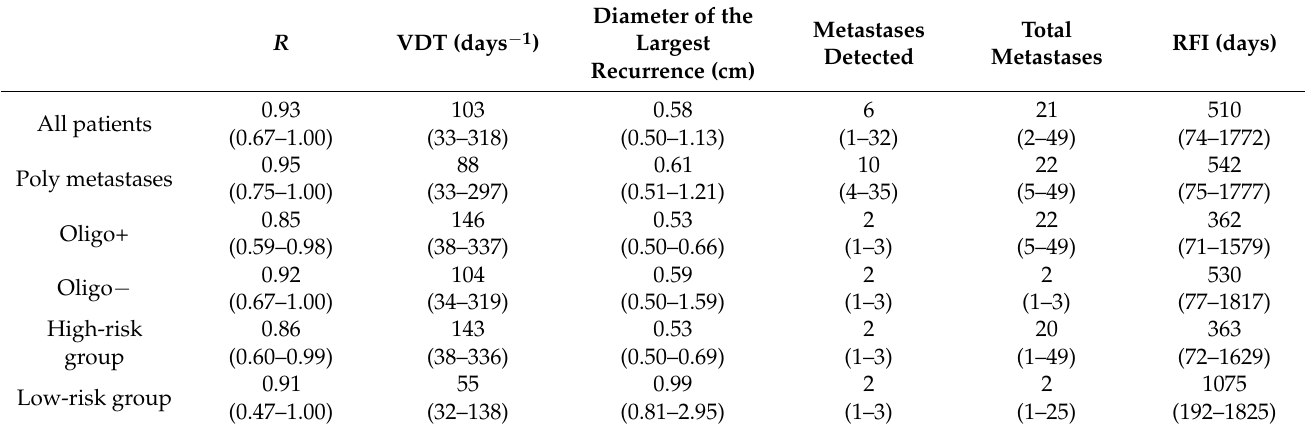
Table 2. Description of the generated patient-level data (the median, with the 2.5% and 97.5% percentiles in brackets).